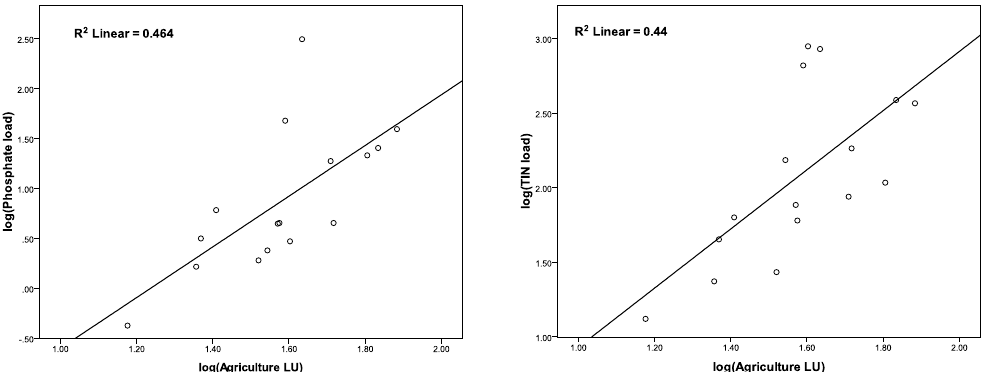
Figure 8. Scatter plots showing the linear relationship between phosphate loads and agriculture land use in the catchment ( left plot) and total inorganic nitrogen load with agriculture in the catchment ( right plot).